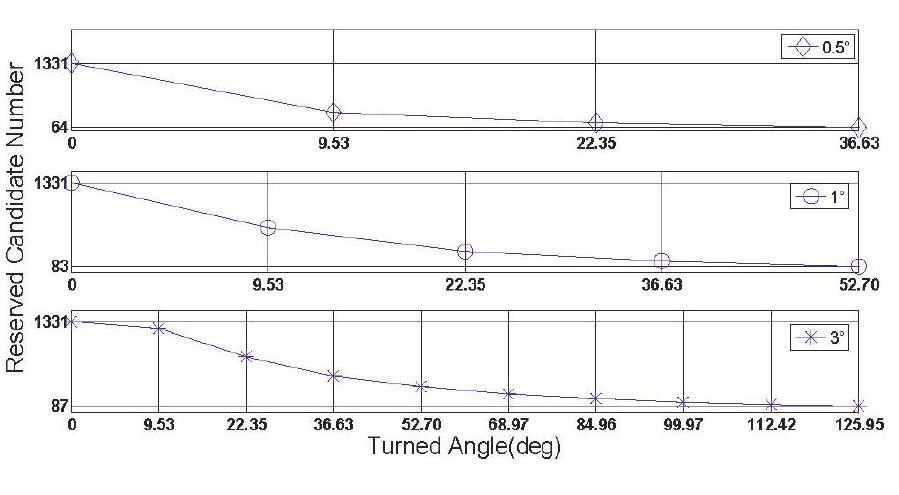
Figure 16. Size of the search space obtains a steady status for each